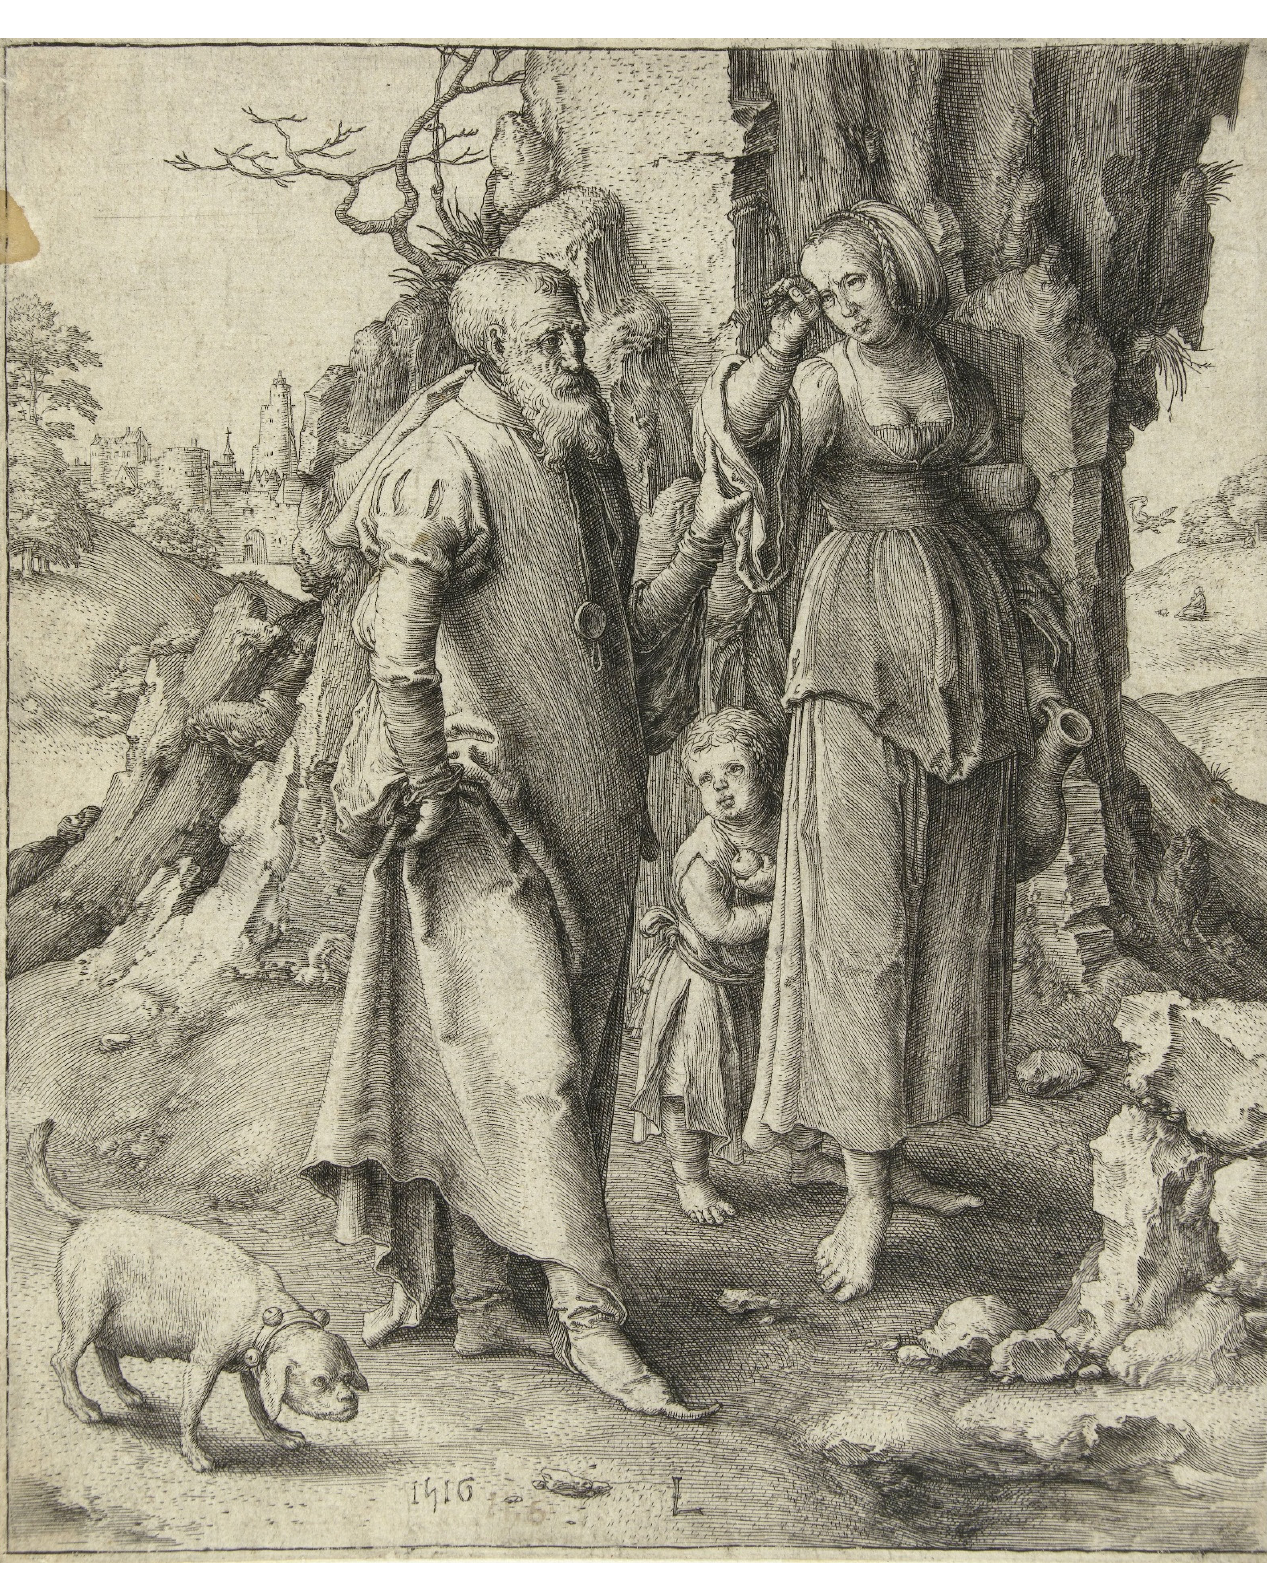
Figure 7. Lucas van Leyden, 1516. Amsterdam, Rijksmuseum, RP-P-OB-1589. We can find these considerations in an oil painting on panel, the work of Jan Mostaert (ca. 1520–1525, Madrid, CThy, 294 [1930.77]) (Figure 8), where the event takes place in the midst of a panoramic cycle that shows Hagar and Ishmael’s expulsion in the foreground